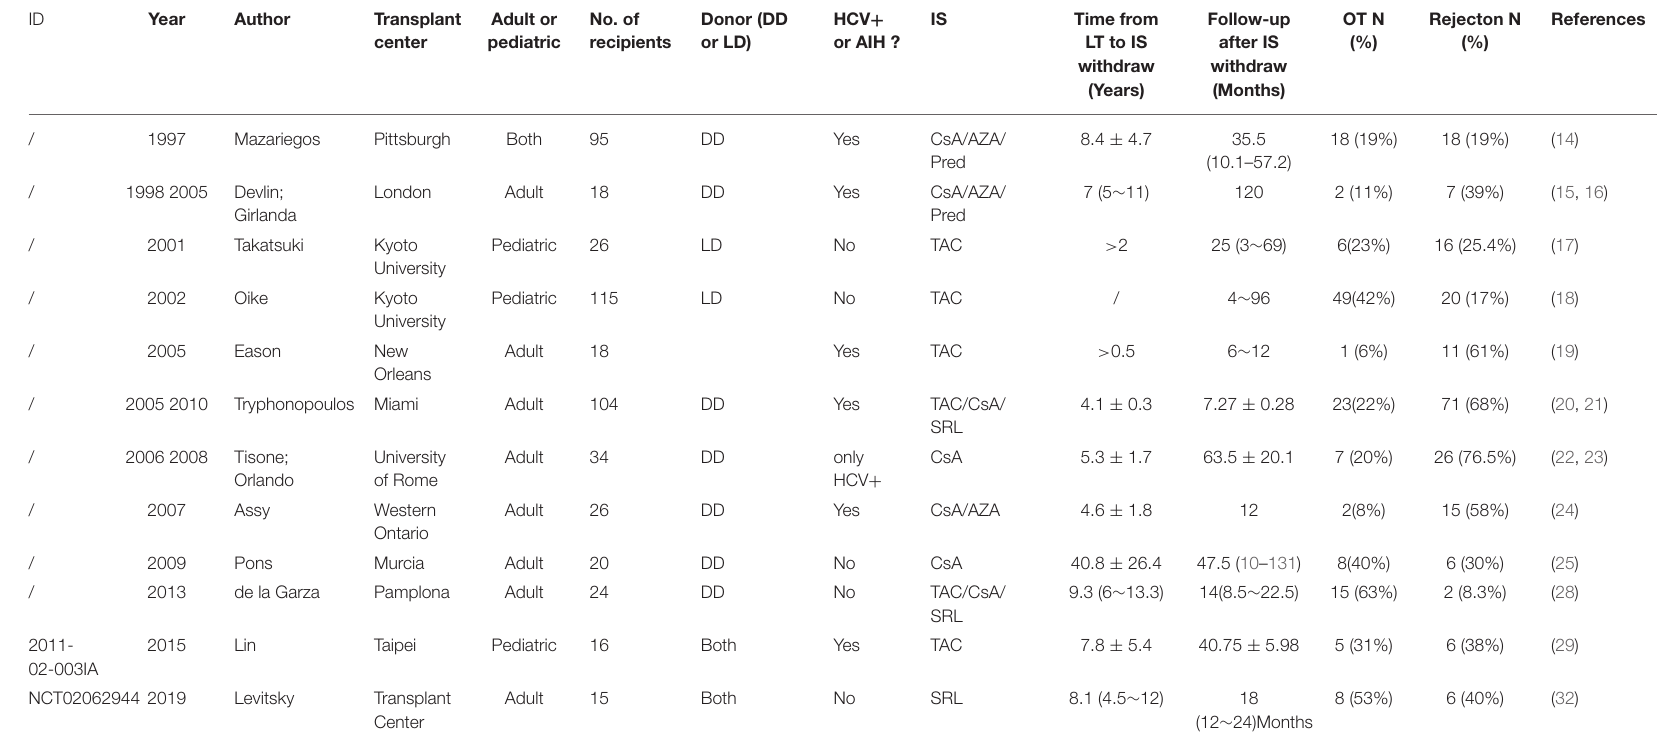
TABLE 1 | Immunosuppression withdrawal trials ( ≥ 10 recipients, single